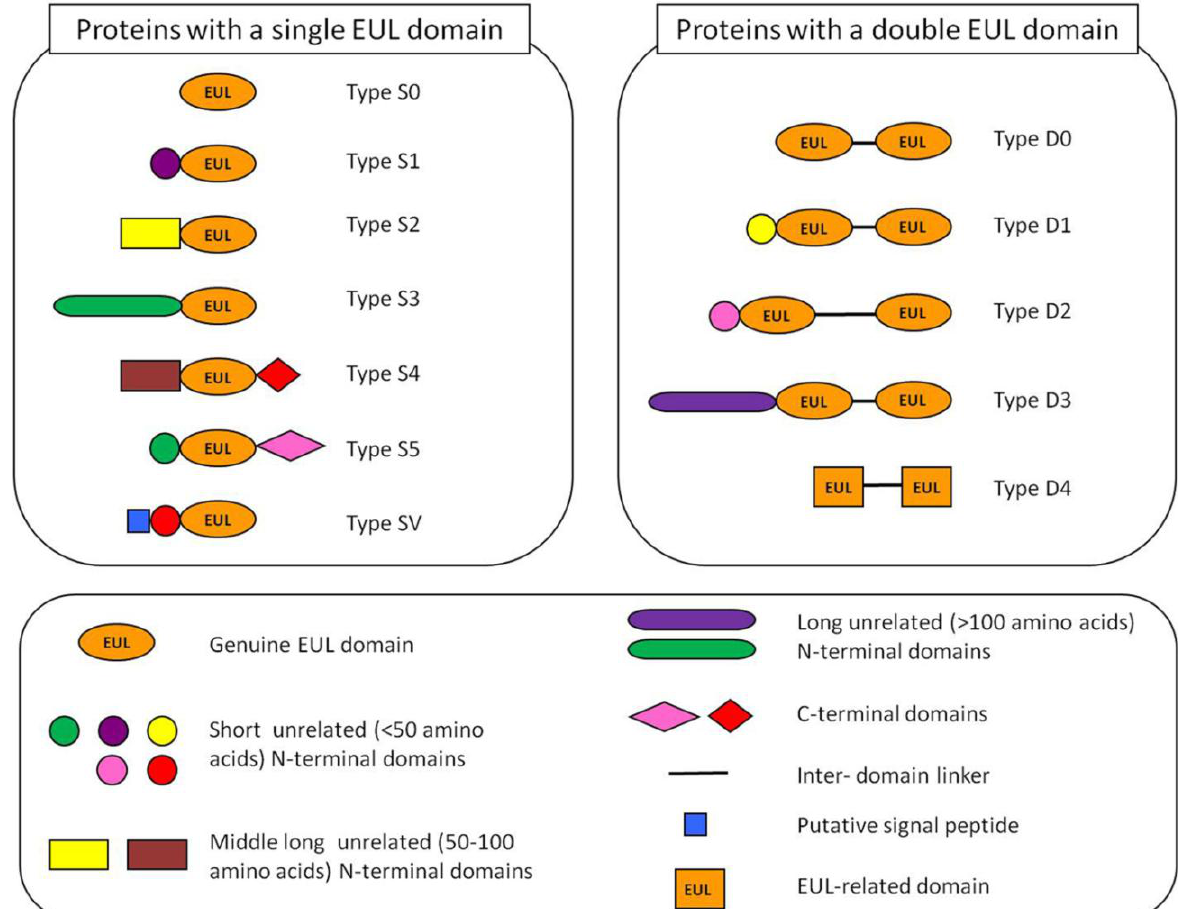
Figure 1 . Schematic representation of the 12 types of Euonymus lectin (EUL)